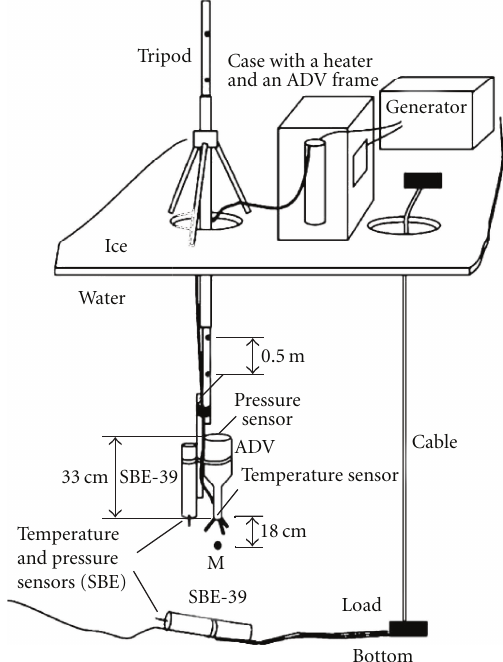
Figure 3: Schematic location of the measuring devices (M corre- sponds to the current measurement